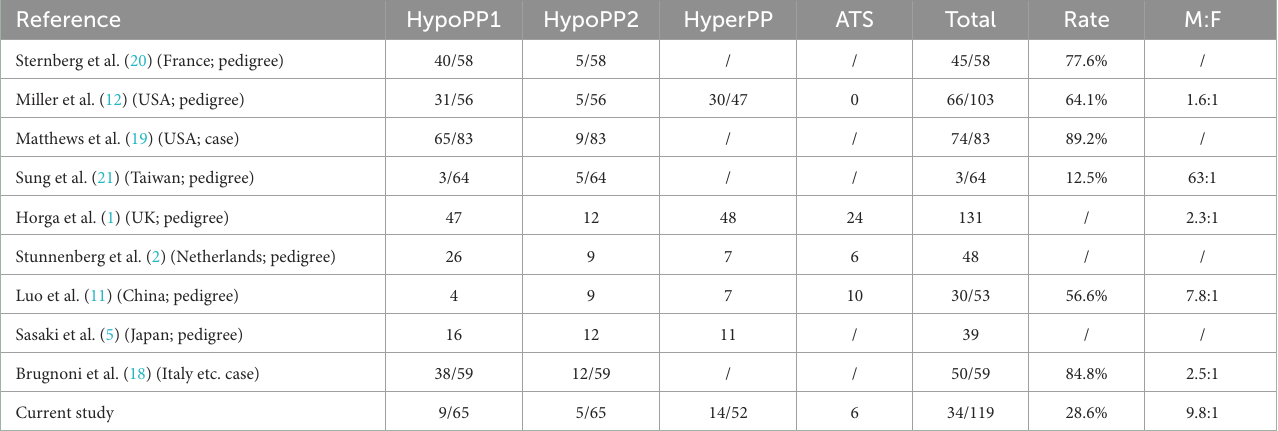
TABLE 2 Literature review of large-group studies for patients with